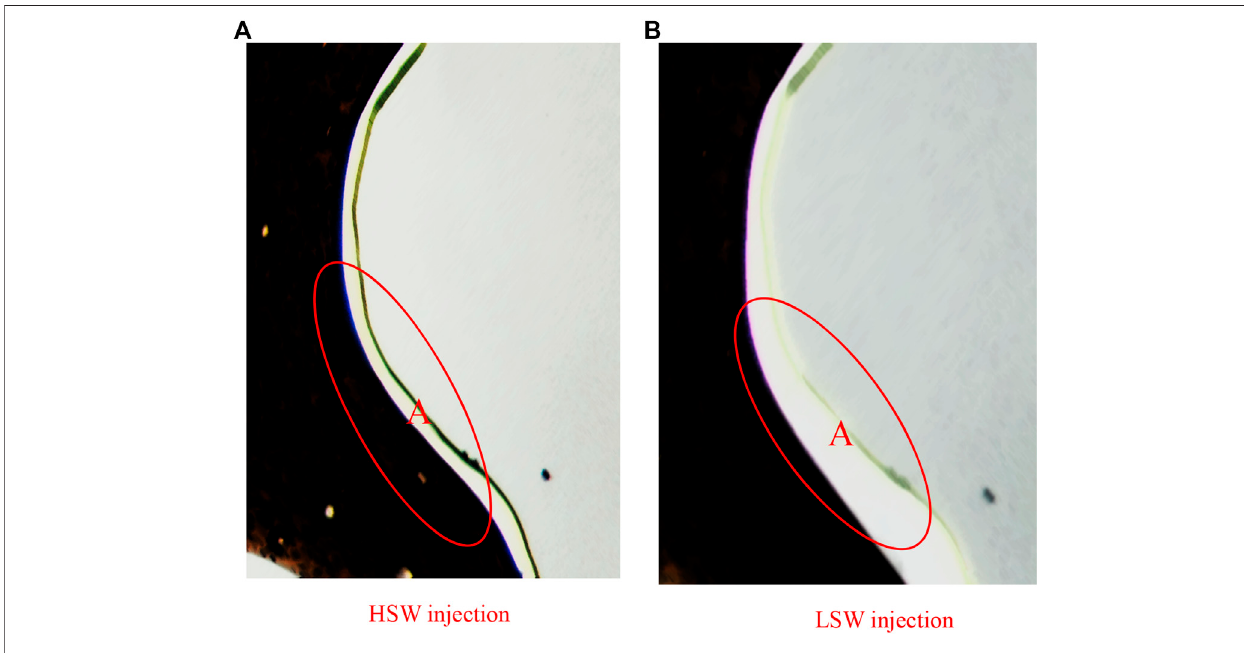
FIGURE 8 | Wetting properties of m ontmorillonite micromodels during (A) HSW injection and (B) LSW injection.